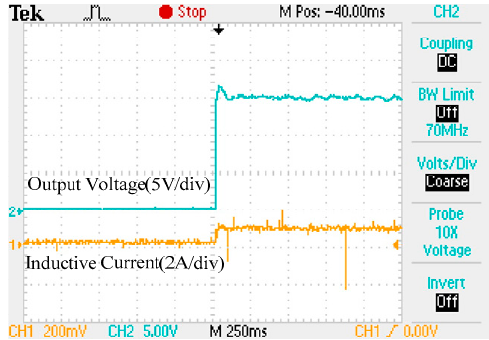
Figure 11. Experimental start ‐ up waveforms of the output voltage and inductive current under the proportional integral derivative (PID) controller.